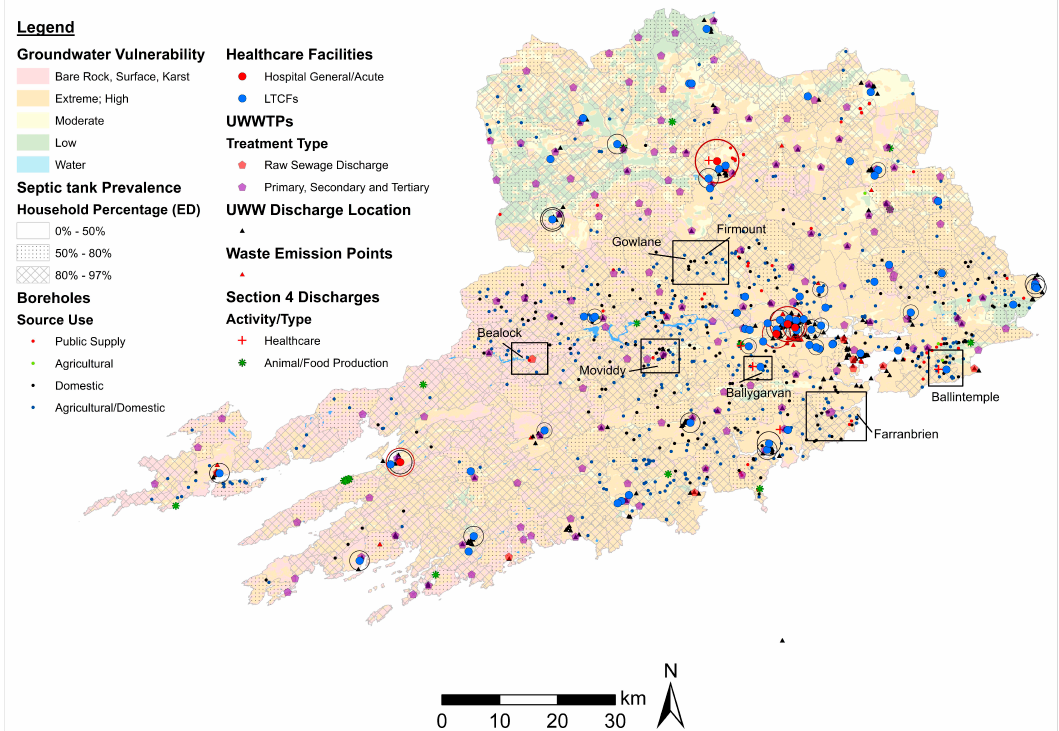
Figure 10. Map of groundwater vulnerability in County Cork. Notes: Boreholes, wastewater AROs sources, and (ED) septic tank prevalence are also included. Buffers around healthcare facilities reflect rates of AM use/consumption (red = hospital/general acute; black = LTCFs). EDs considered suitable for sampling are highlighted. ED = electoral district. UWWTPs = urban wastewater treatment plants. UWW = urban